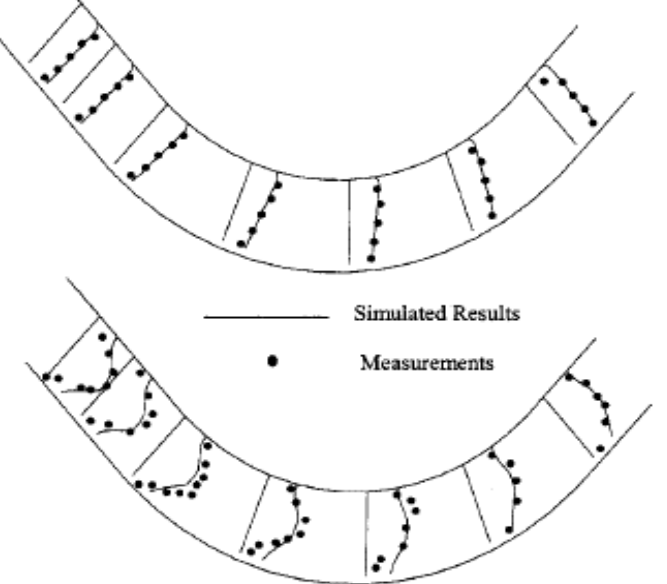
Figure 13. Comparison of simulated and measured depth-averaged velocity and concentration field (Reproduced from Duan (2004) [50] with permission from ASCE).